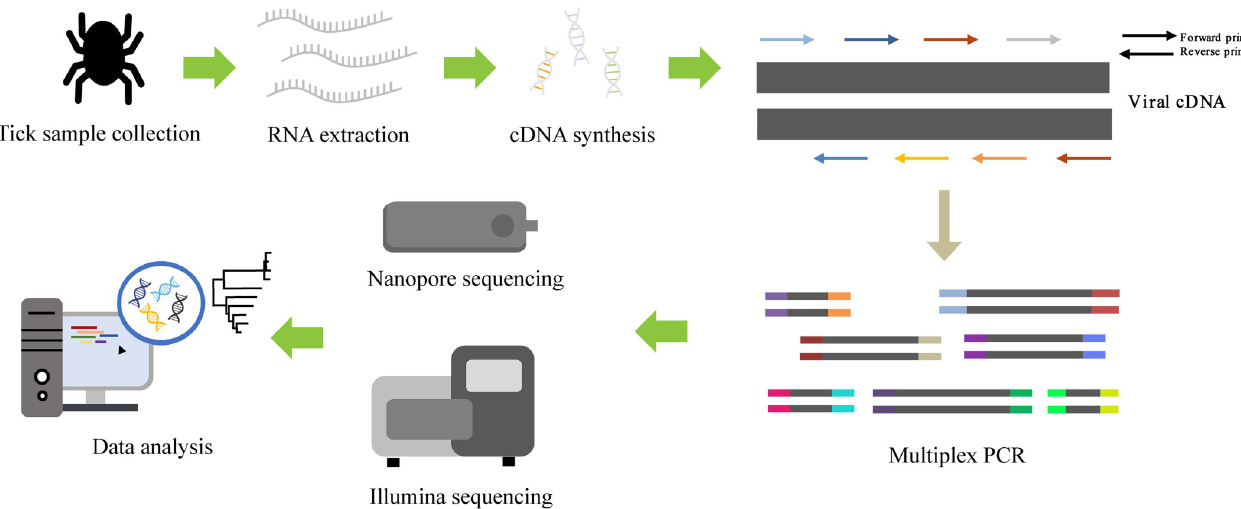
Fig 2. Workflow overview of multiplex PCR-based next-generation sequencing for whole-genome sequencing of severe fever with thrombocytopenia syndrome virus (SFTSV). Total RNA was extracted from tick samples and cDNA was synthesized with SFTSV-specific oligonucleotide primer (SFTSV-PHS). cDNA was enriched using designed SFTSV-specific primer mixtures for the next-generation sequencing. Amplified libraries were pooled, ligated to sequencing adapter, and sequenced using nanopore and Illumina sequencing according to each manufacturer’s instructions. Raw data were filtered and analyzed by CLC Genomics Workbench